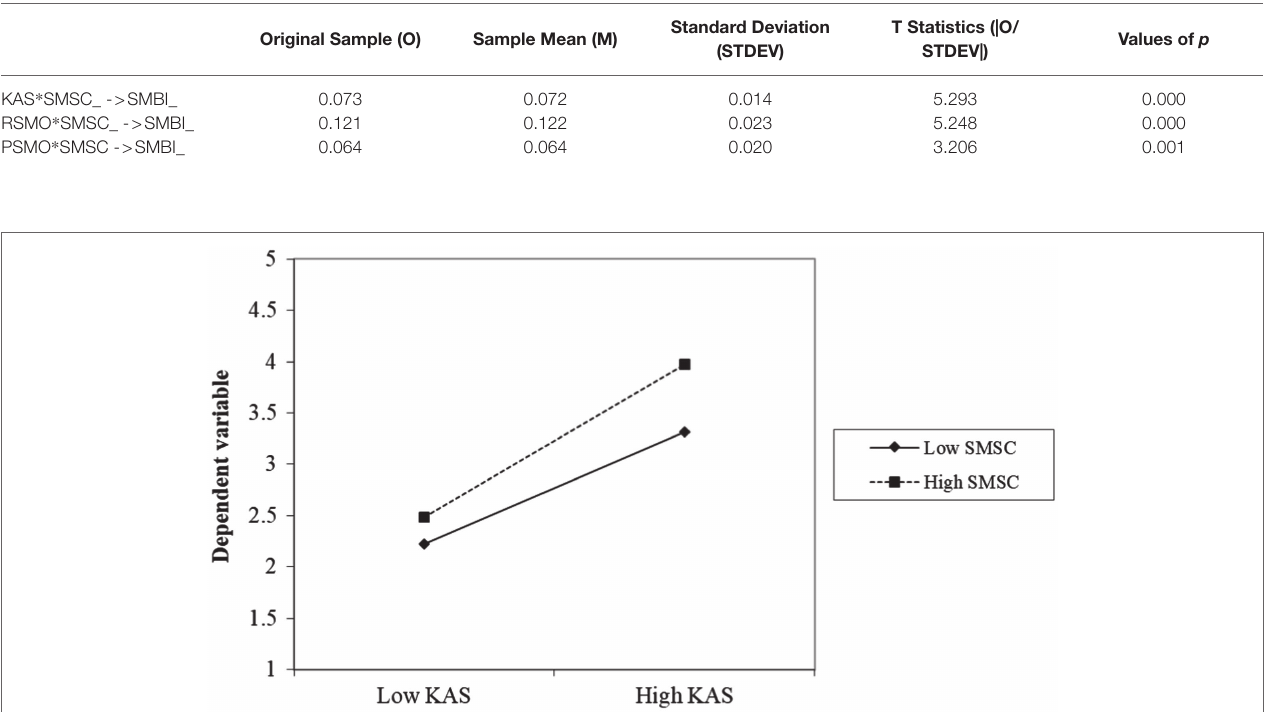
TABLE 5 | Hypothesis testing result moderating